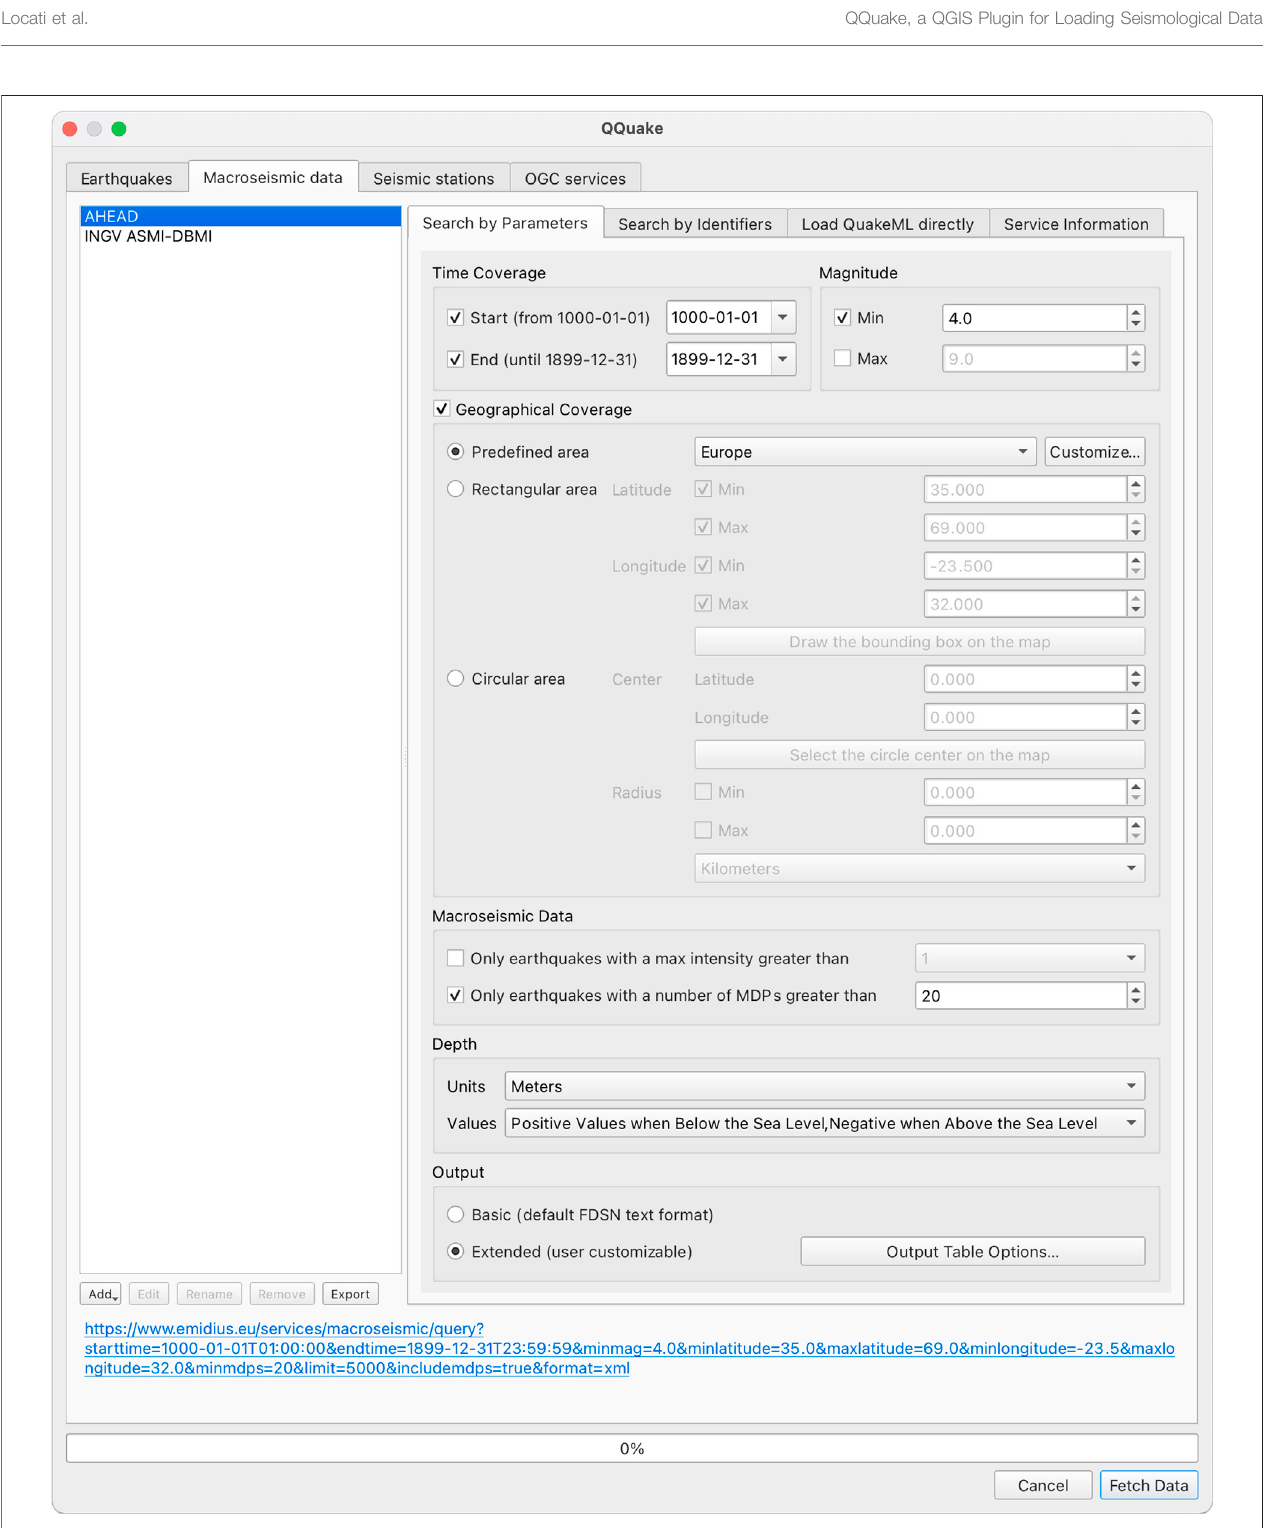
FIGURE 2 | Screenshot of the plugin GUI. Example section “ Macroseismic data ” with the data source “ AHEAD ” selected, and all query parameters that the user may apply.